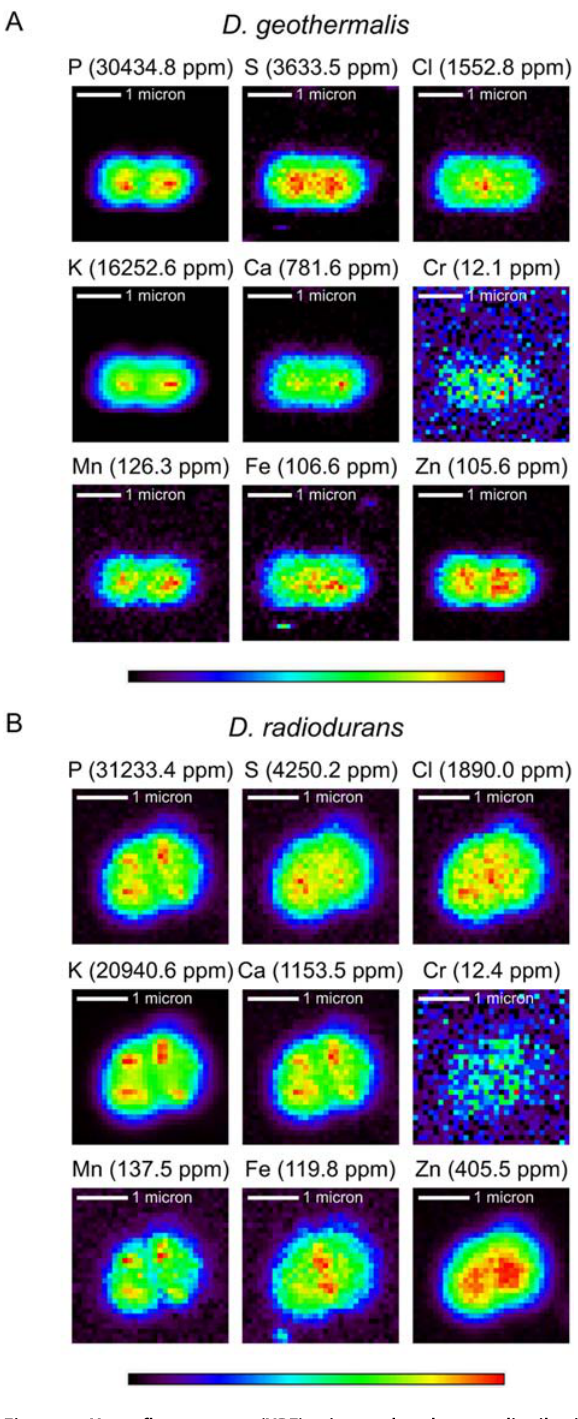
Figure 7. X-ray fluorescence (XRF) microprobe element distribution maps [ 142 ] . A , D. geothermalis (diplococcus). B , D. radiodurans (tetracocus). Cells were harvested from mid-logarithmic cultures in undefined rich medium, imaged, and quantified as described previously [17]. The element distribution images are plotted to different scales designated by a single color-box, where red represents the highest concentration and black the lowest. ppm values in parentheses next to the element symbol correspond to red. XRF microprobe analysis measurements were made at beamline 2ID-D at the Advanced Photon Source, Argonne National Laboratory as described recently